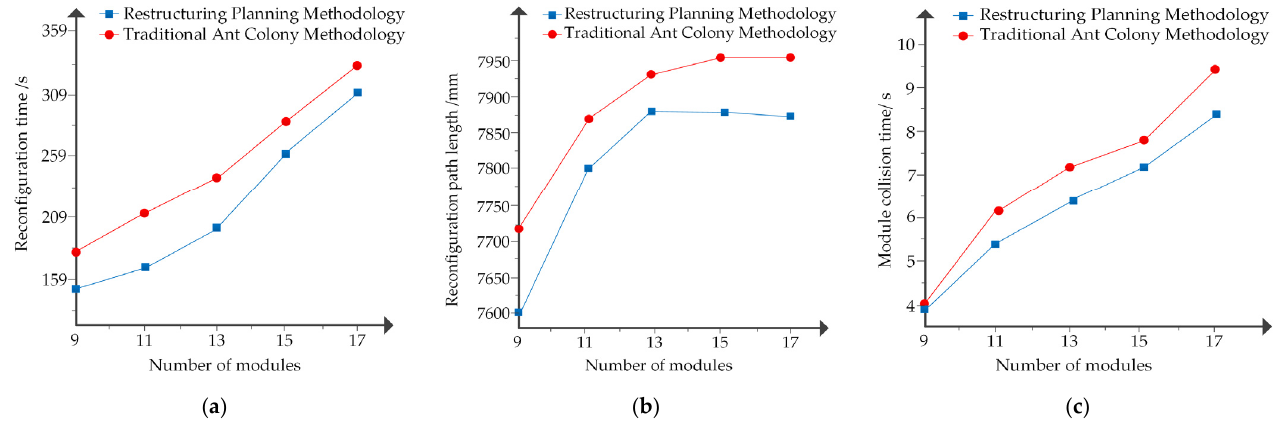
Figure 16. Module collaborative path planning diagram. ( a ) Robot configuration reconstruction planning time, ( b ) Robot configuration reconstruction plan path length, ( c ) Collision avoidance time of robot configuration module.